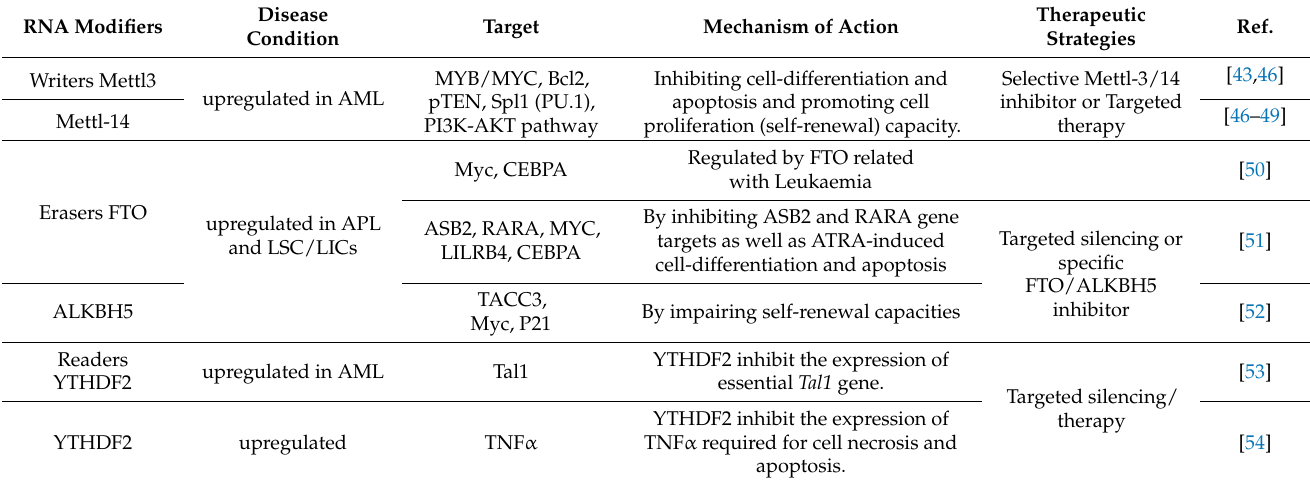
Table 2. Players of RNA epigenetic machineries as therapeutic targets in